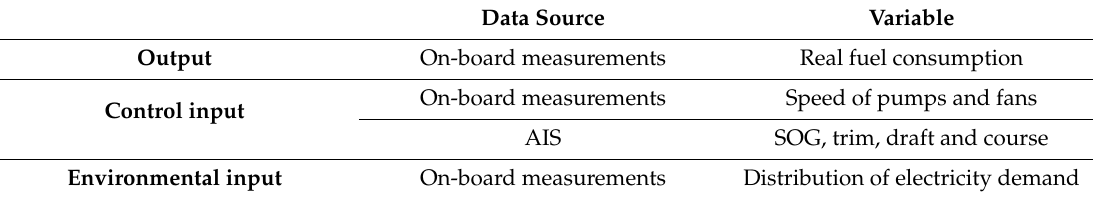
Table 1. Sources and variables from real data. AIS: Automatic Identification System and SOG: speed over